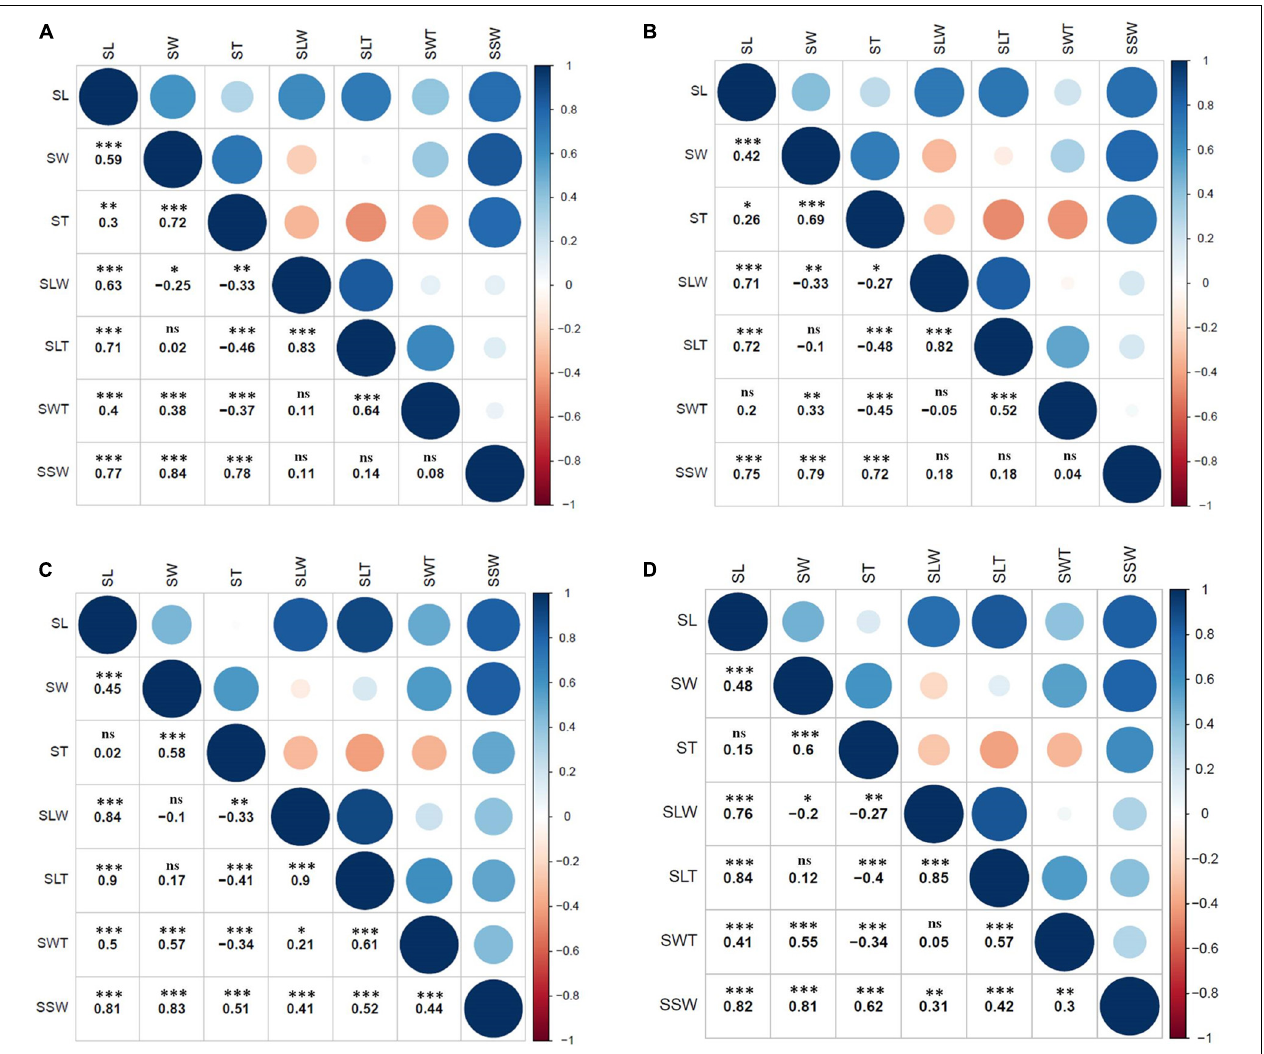
FIGURE 2 | Pearson’s correlation analysis of seven seed size and shape traits among RILs ( n = 94) within or across environments; (A) 2012, (B) 2016, (C) 2017, and (D) combined (mean values of 3 years). ∗ , ∗∗ , and ∗∗∗ indicate significant correlations at the 5%, 1%, and 0.1% level, respectively; ns indicates no significant correlation at the 5%